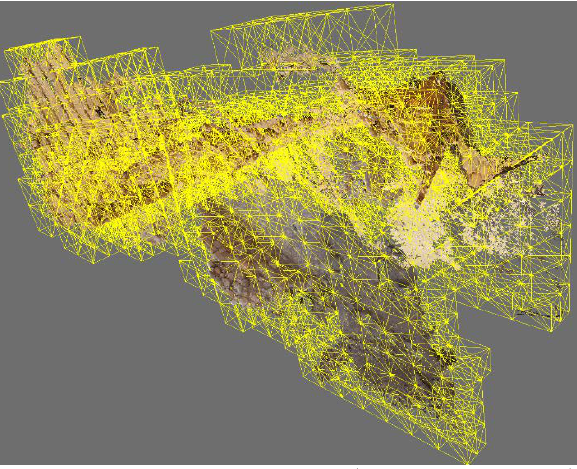
Figure 1 Octree leaves for a 3D model (Shawbak castle,